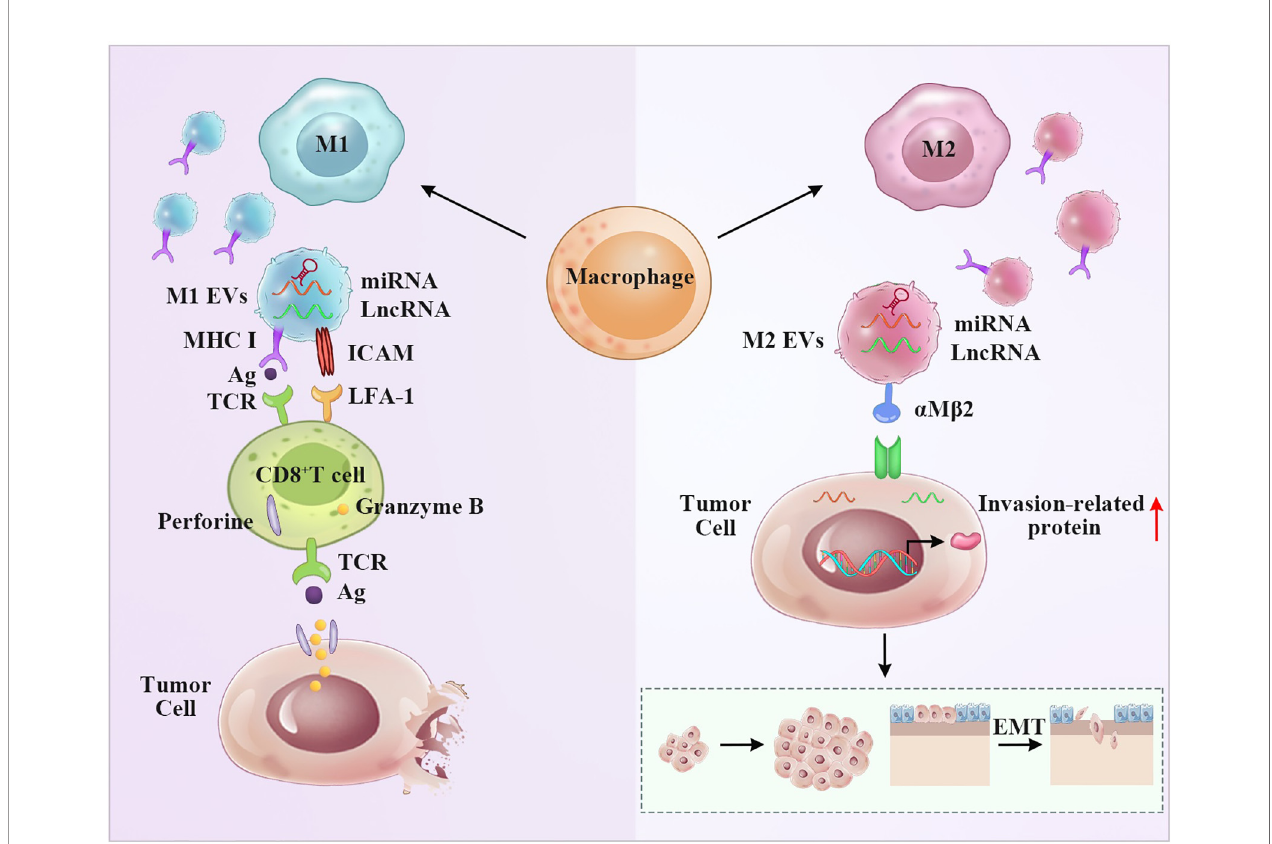
FIGURE 2 | M1 and M2 macrophage-derived EVs display the opposite anti-tumor effect. Left panel: The presence of MHC and ICAM molecules on the surface of M1 EVs give them the potential to stimulate T cells, resulting T cell activation and tumor apoptosis. The miRNA and LncRNA derived from M1 EVs may aid this process. Right panel: M2 EVs transferred miRNA and LncRNA to regulate invasion-related protein, thus promoting the invasion and metastasis of